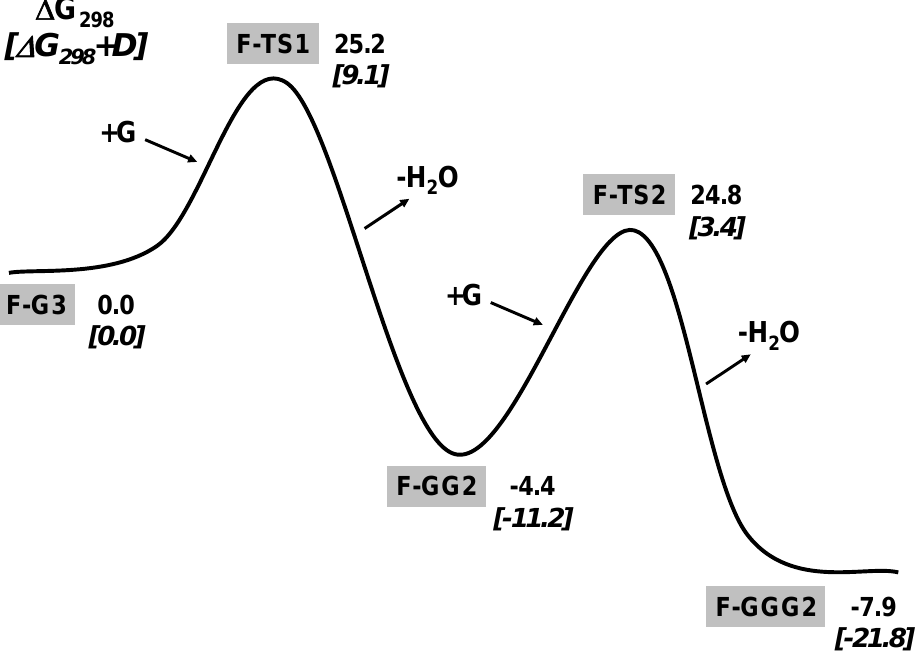
Figure 4. Relative free energy profile (kcal mol -1 ) of the glycine condensation